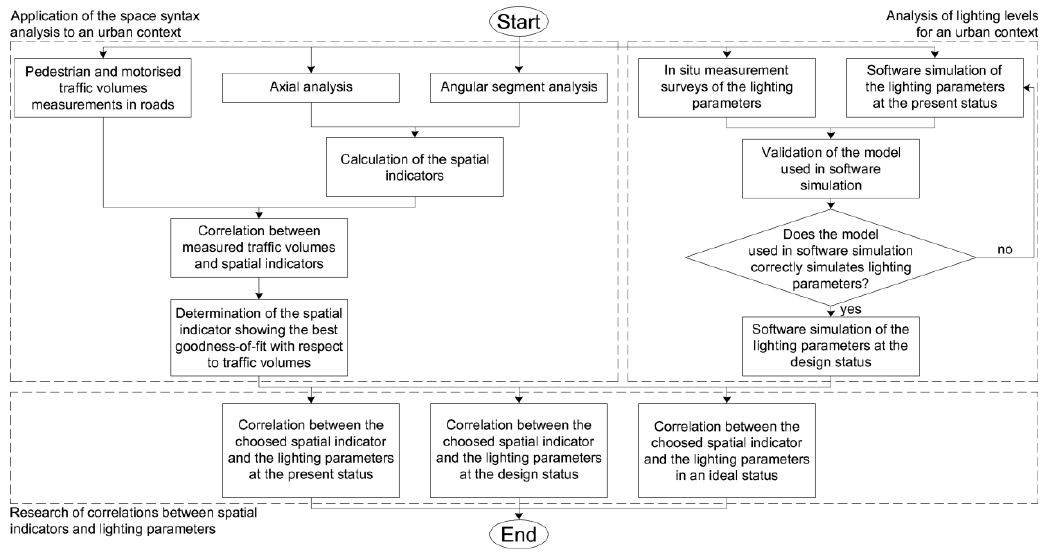
Figure 1. Flowchart showing the phases in which the research has been structured.